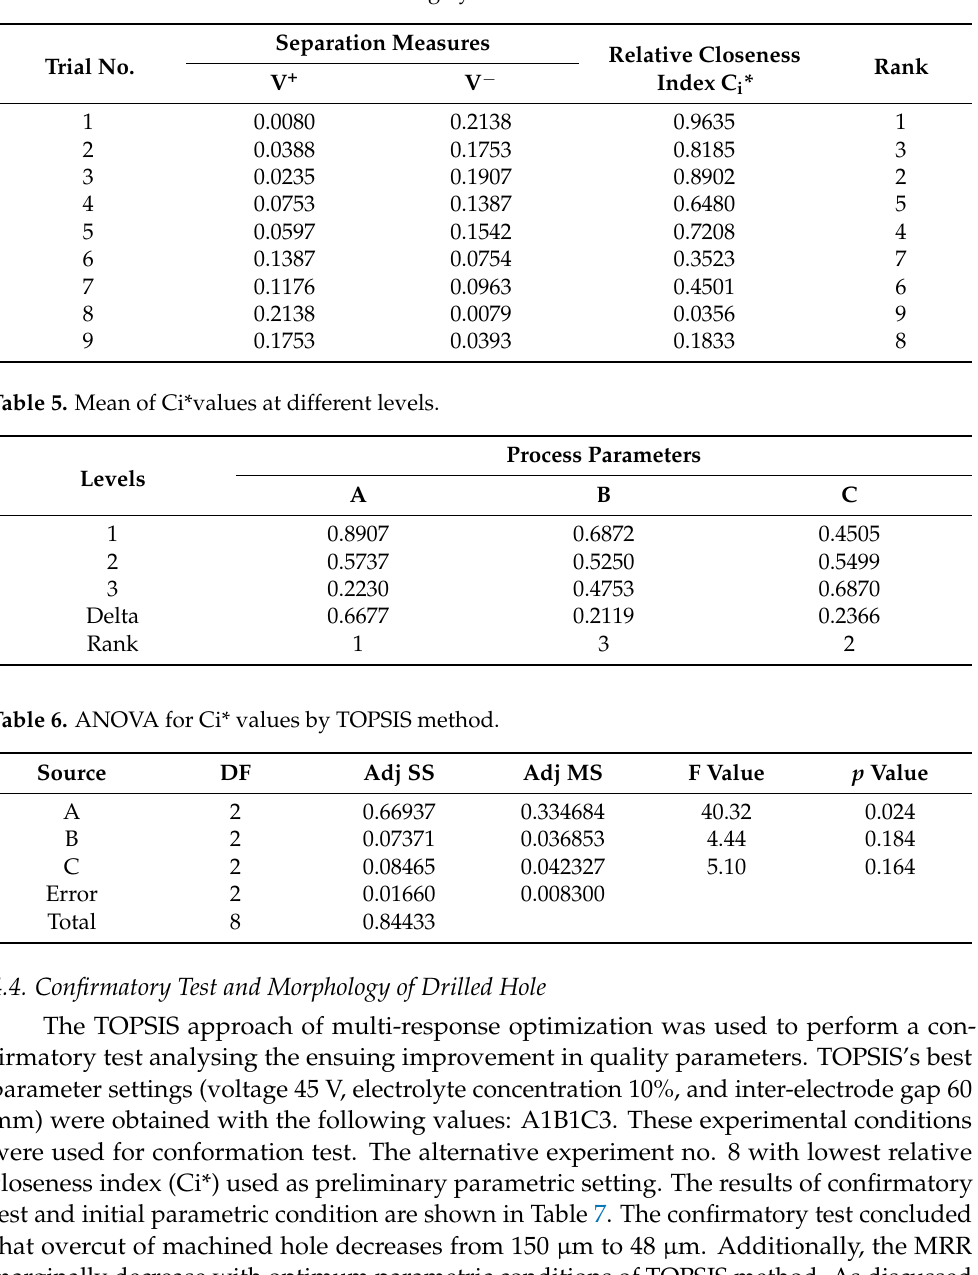
Table 4. Relative closeness index and ranking by TOPSIS method.